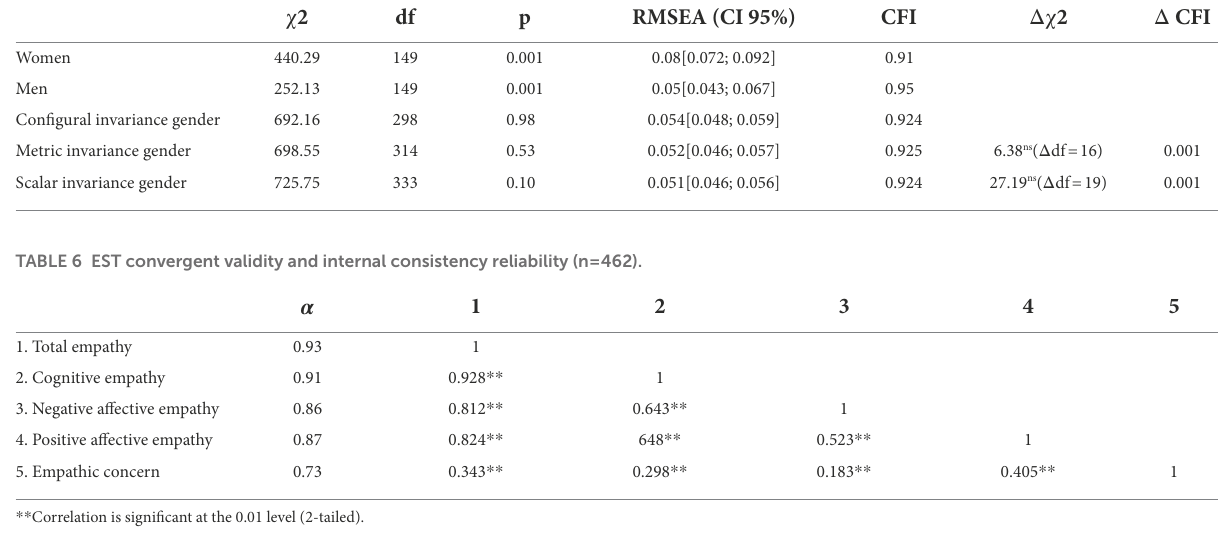
TABLE 5 Fit indices for the invariance test in gender groups.